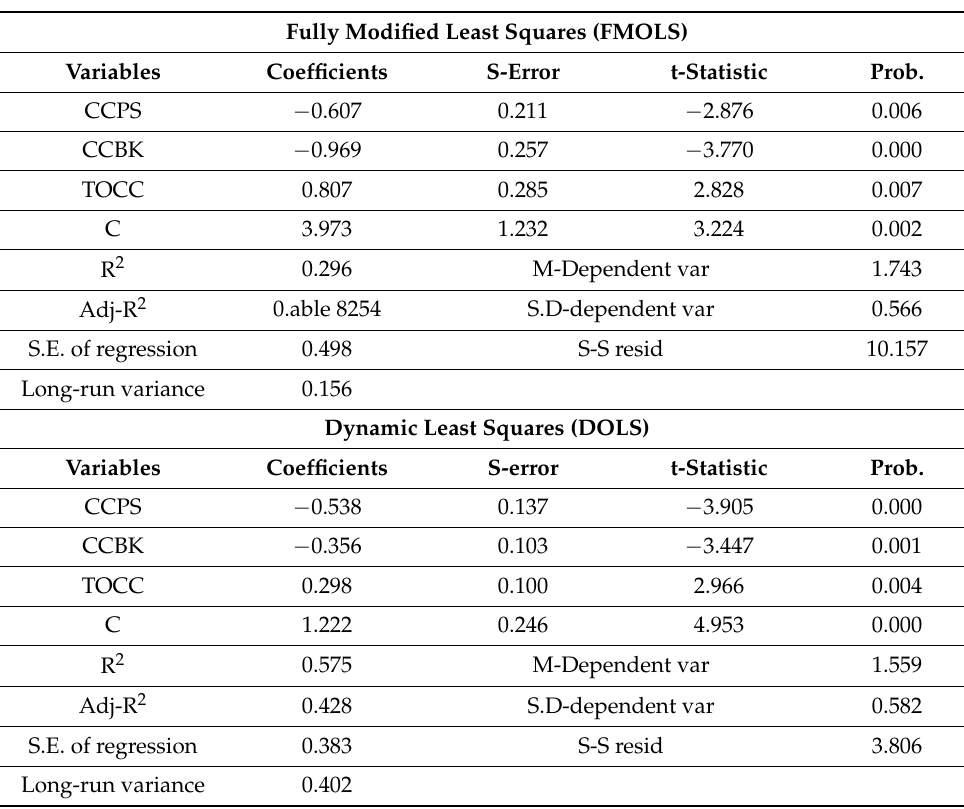
Table 8. Outcomes of FMOLS and